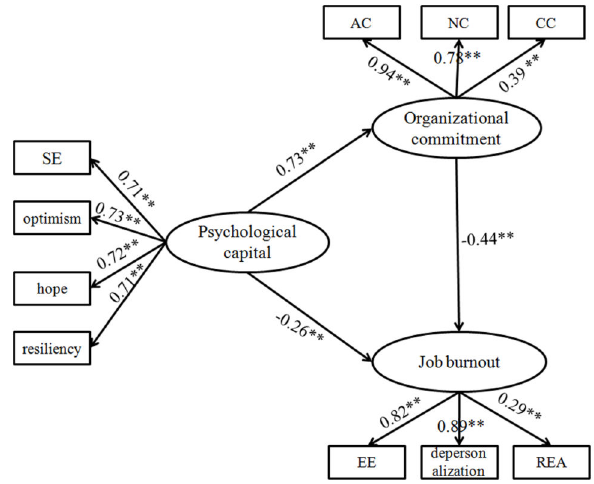
Figure 1. The final structural model (N = 310). Note: Factor loadings are standardized. SE self-efficacy, EE emotional exhaustion, REA reduced personal accomplishment, AC affective commitment, CC continuance commitment, NC normative commitment.